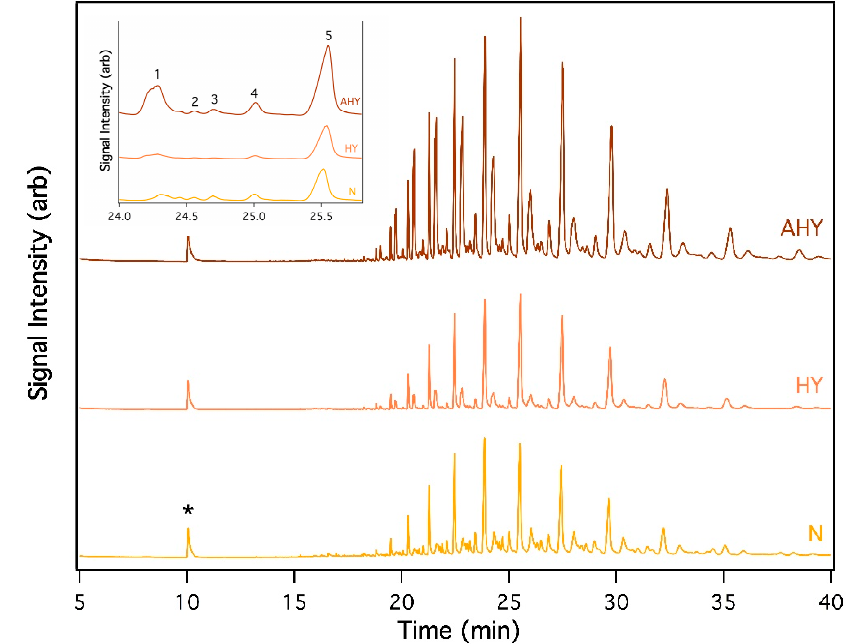
Figure 1. Representative gas chromatograms from uropygial secretions of nestling (N; bottom), hatch year (HY; middle), and adult (AHY; top) house sparrow. Levels of heavy esters (C31–C37) were lower in nestlings (N) than HY ( p < 0.001) or AHY birds ( p = 0.02) and HY birds had lower levels than AHY ( p = 0.013). Lighter esters (C28–C31) were lower in nestlings than HY ( p = 0.03) and AHY ( p < 0.001) birds and HY had lower levels than AHY birds ( p = 0.05). Inset shows an expanded time segment to illustrate the repeated patterns seen in these chromatograms. Peaks 1–5 result from structural isomers with different extents of branching. The asterisk designates the internal standard, benzyl alcohol.